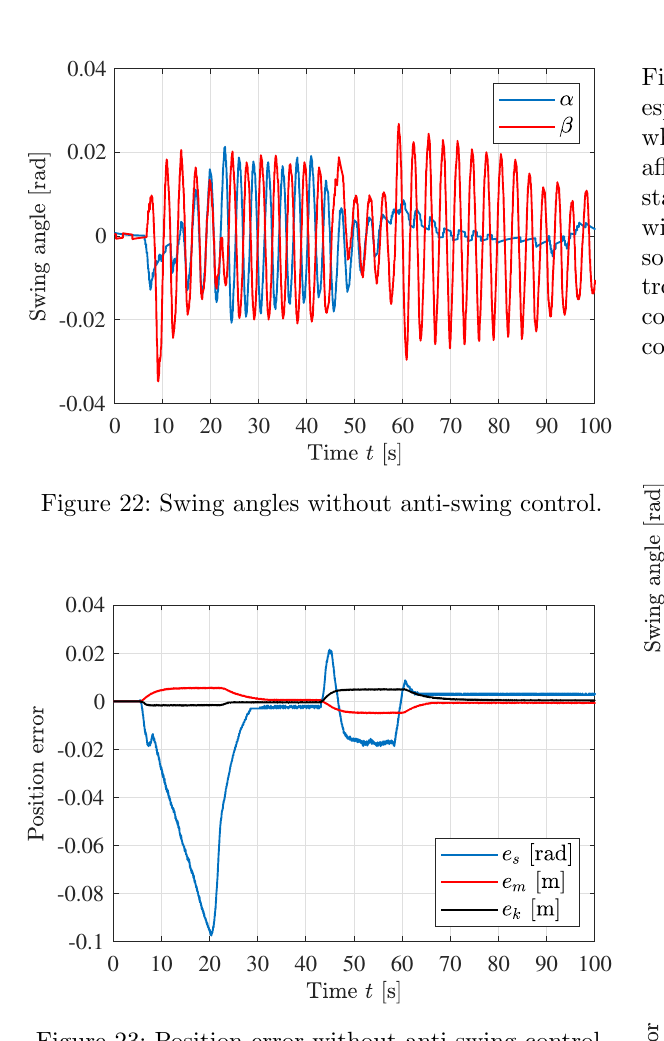
Figure 23: Position error without anti-swing control.